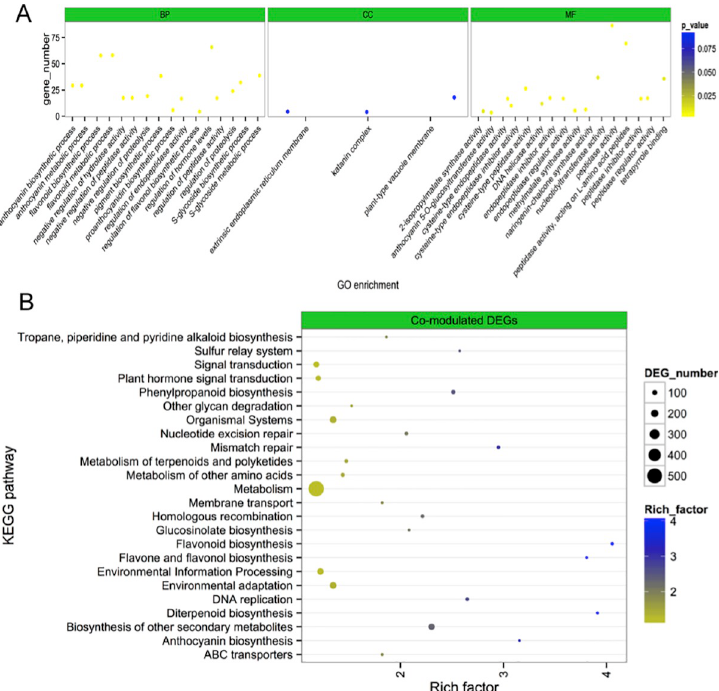
Fig 3. Functional enrichment analysis of differentially expressed genes (co-modulated DEGs) in radish. (A) Enriched GO terms of co-modulated differentially expressed genes related to anthocyanin synthesis in radish. (B) Pathway enrichment analysis of differentially expressed genes related to anthocyanin synthesis in radish. KEGG pathways were plotted on the ordinate, and the enrichment factor (rich factor) was plotted on the abscissa. The color of points represents the q-value, and the size of points represents the number of DEGs mapped to the reference pathway. Legends for the color scale of q-values and size-scaling of the number of DEGs are shown to the right of the plot.